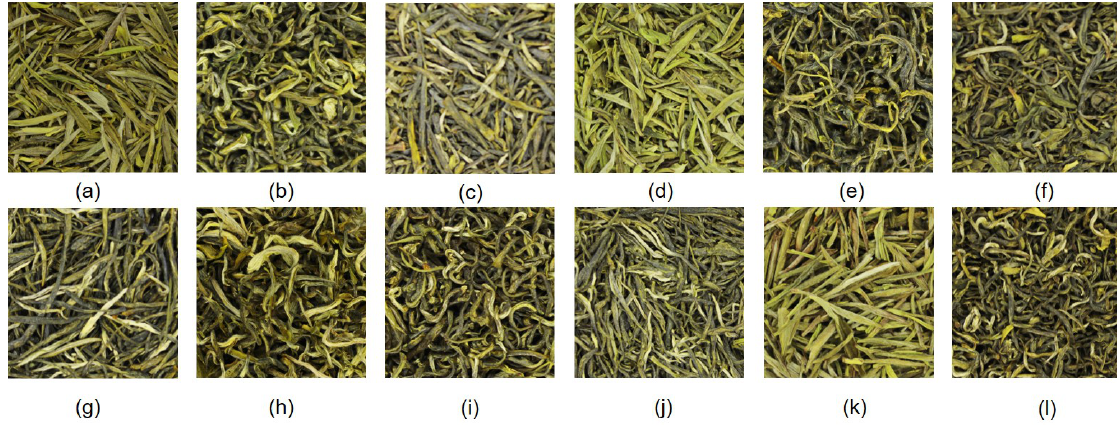
Figure 3. Photos of the 12 green teas. ( a ) HSMF; ( b ) YDMF; ( c ) EMMF; ( d ) LXMF; ( e ) QSMF; ( f ) MTMF; ( g ) XYMJ; ( h ) GLMJ; ( i ) DYMJ; ( j ) GZMJ; ( k ) QSMJ; ( l ) ZYMJ.